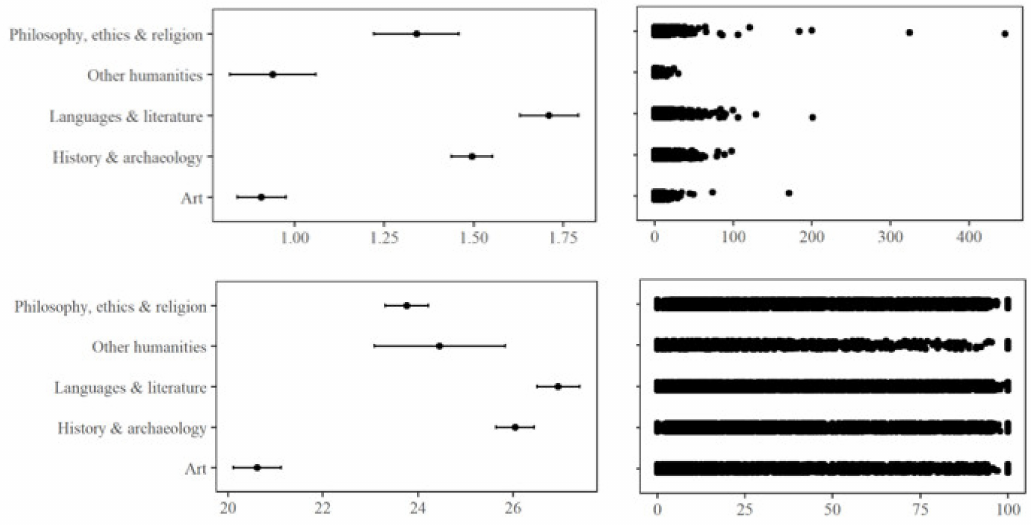
Figure 3. 95% confidence interval and scatter graphs for subareas of the humanities, based on journal data for citations per publication (first line) and percentage of documents cited (second line).